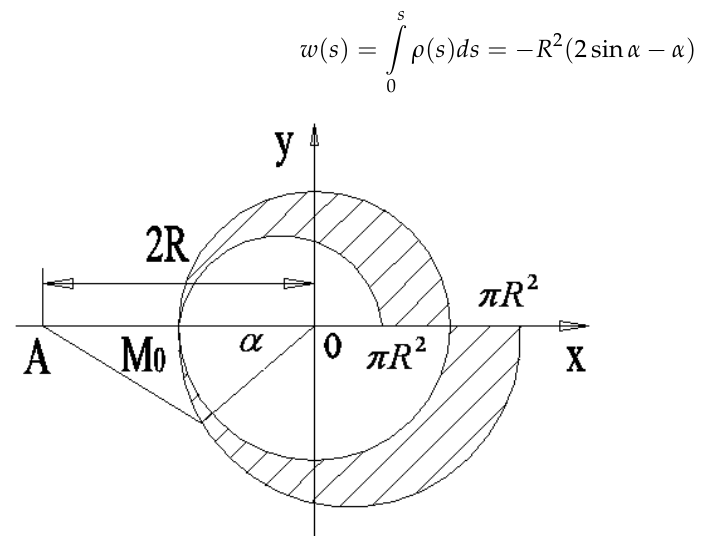
Figure 5. The fan area of the open-ring section.